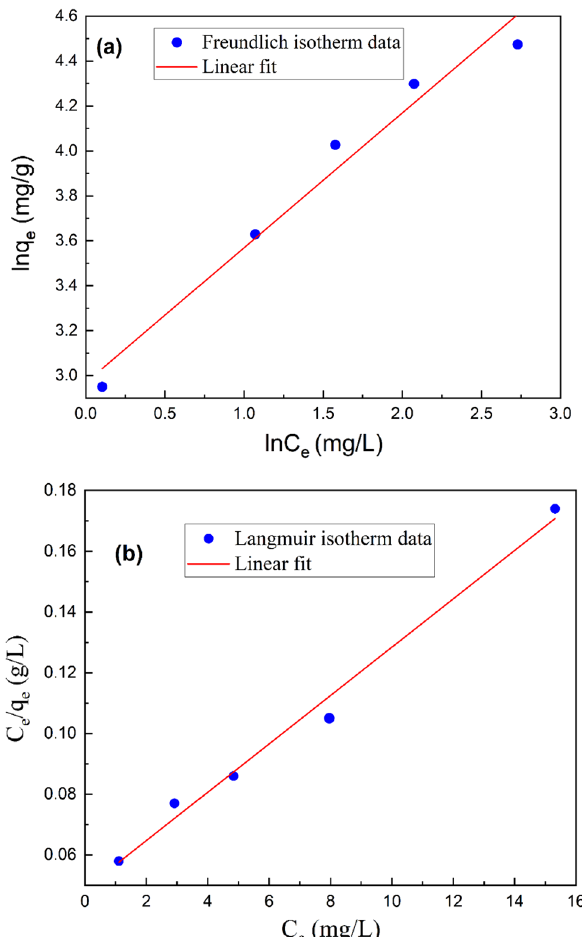
Figure 7. Freundlich ( a ) and Langmuir isotherms ( b ) for adsorption of Cd(II) onto HAp/bentonite composite.